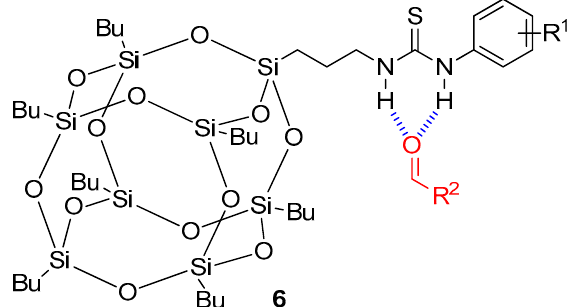
Figure 6. Chemical structure of thiourea-based profragrances 6 , highlighting the aldehyde scent and the hydrogen bonds. The original results were reported by Zhu and coworkers [47].